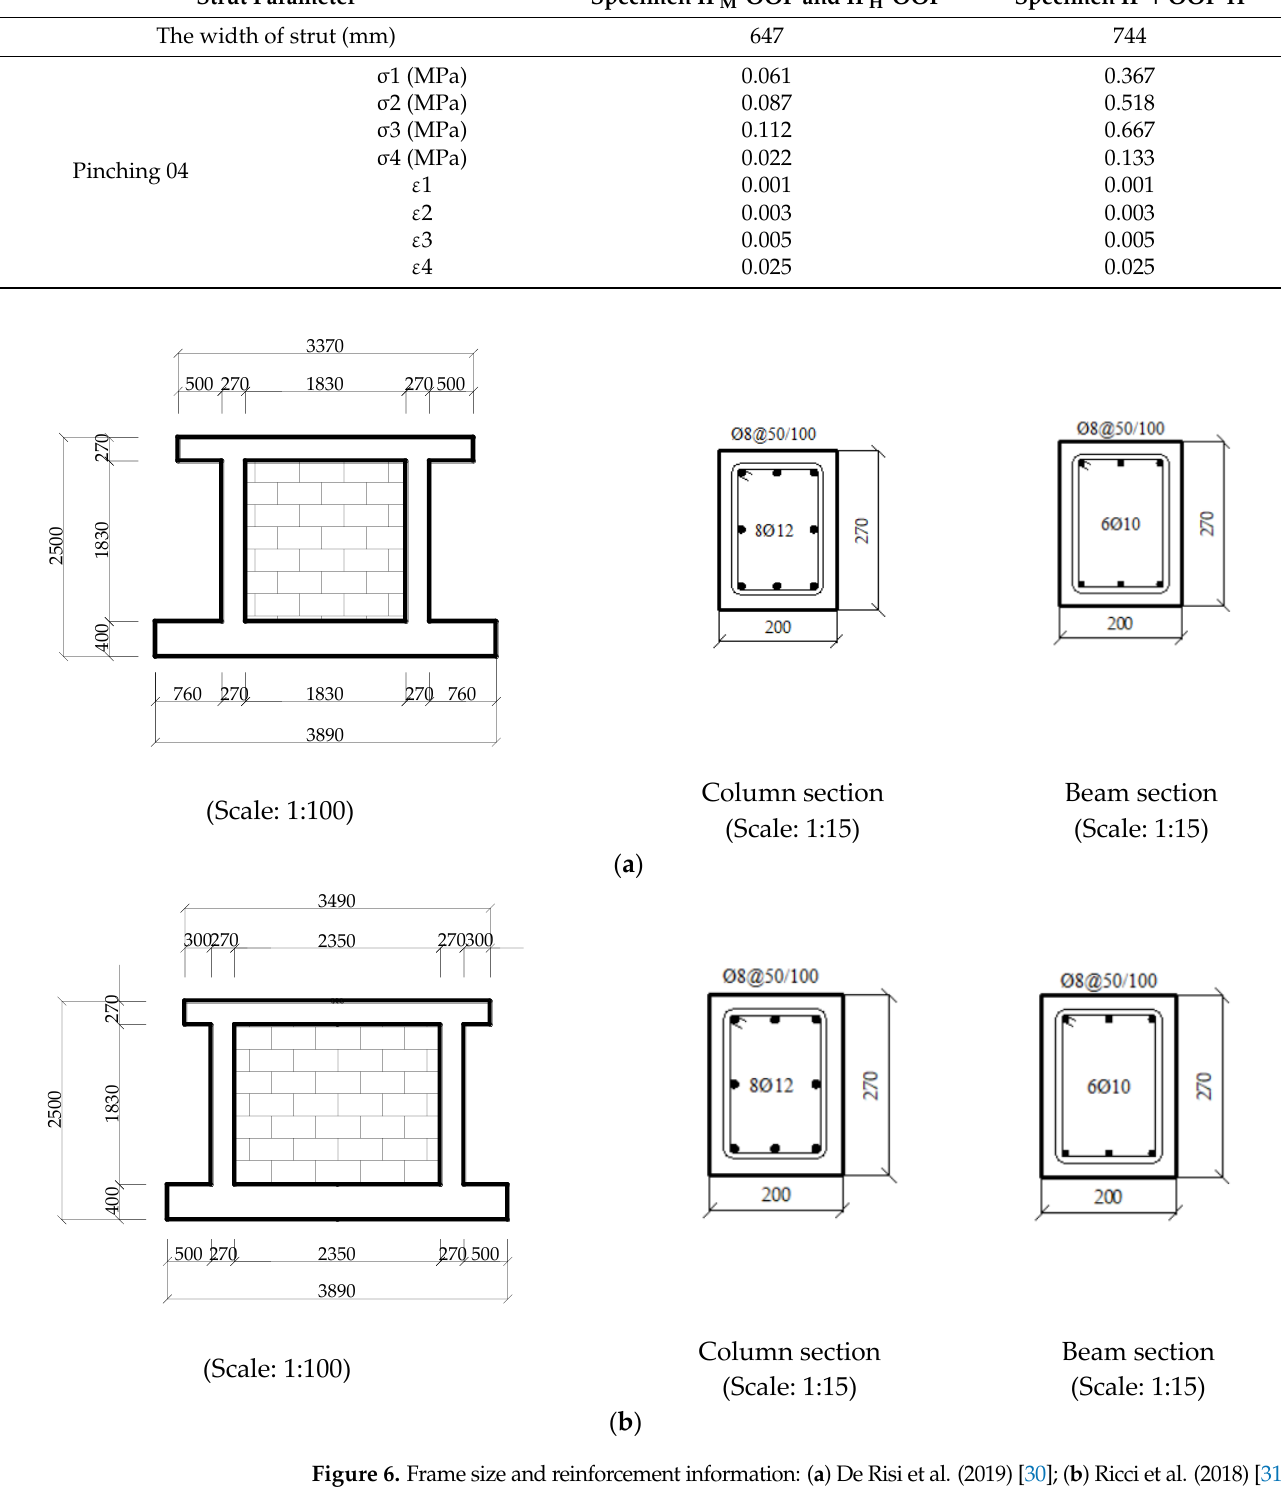
3 Table 7. Modeling parameters of the elastic – plastic central strut. Strut Parameter